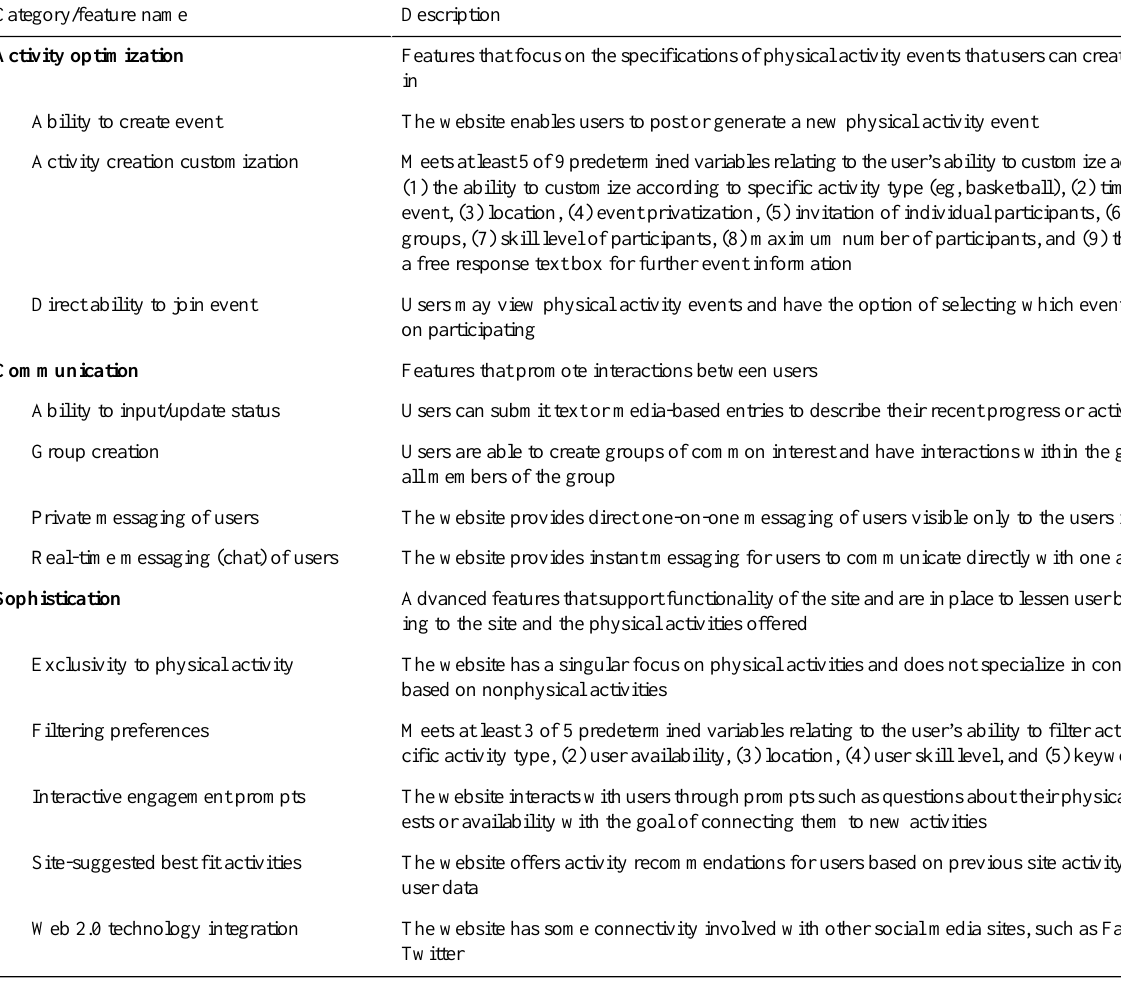
Table 1. Description of key features and